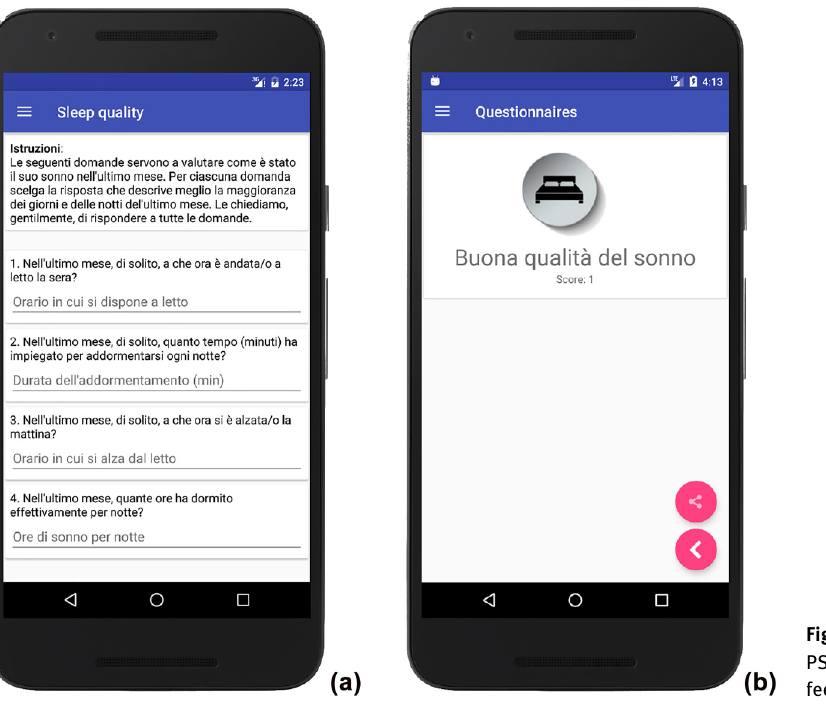
Figure 5: Questionnaires: